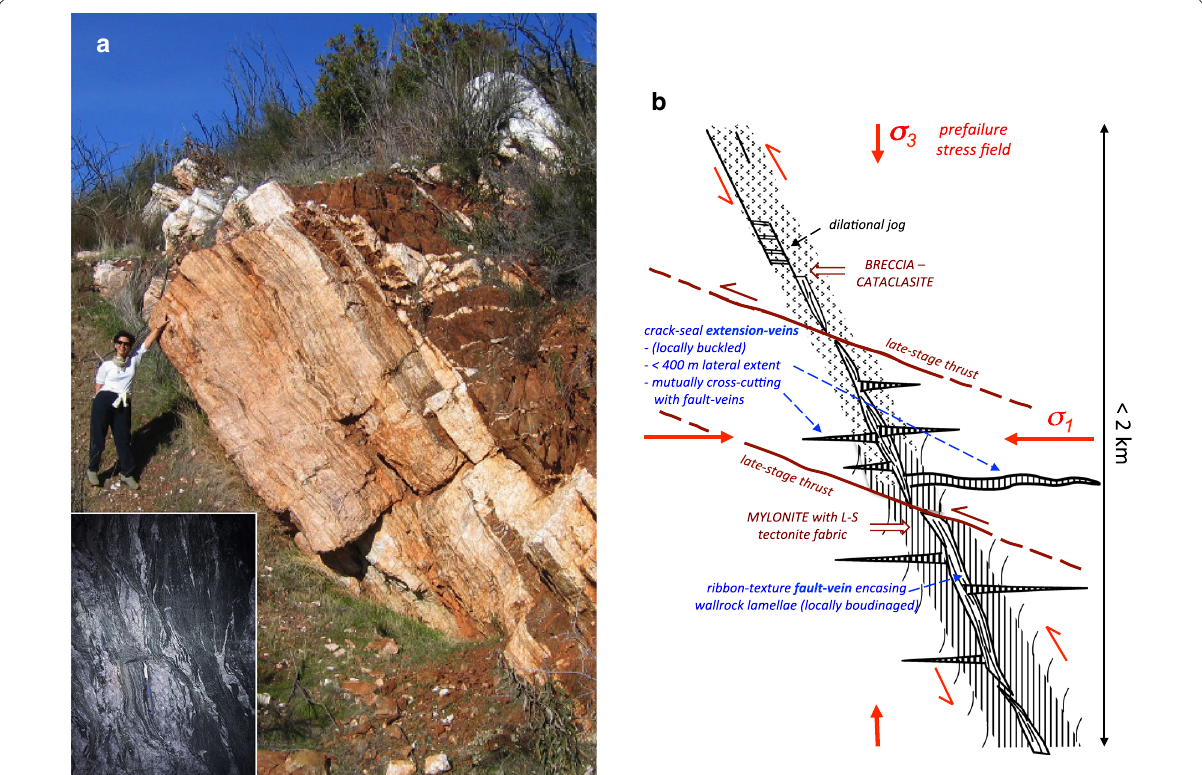
Fig. 5 a Mother Lode Au–quartz vein system hosted near Melones Fault, Coulterville, CA; inset at lower left shows Au–quartz veins boudinaged in steep reverse-sense ductile shear zone, Ferderber Mine, Val d’Or, Quebec. b Structural characteristics of fault-valve vein systems hosted on steep reverse faults (schematic and